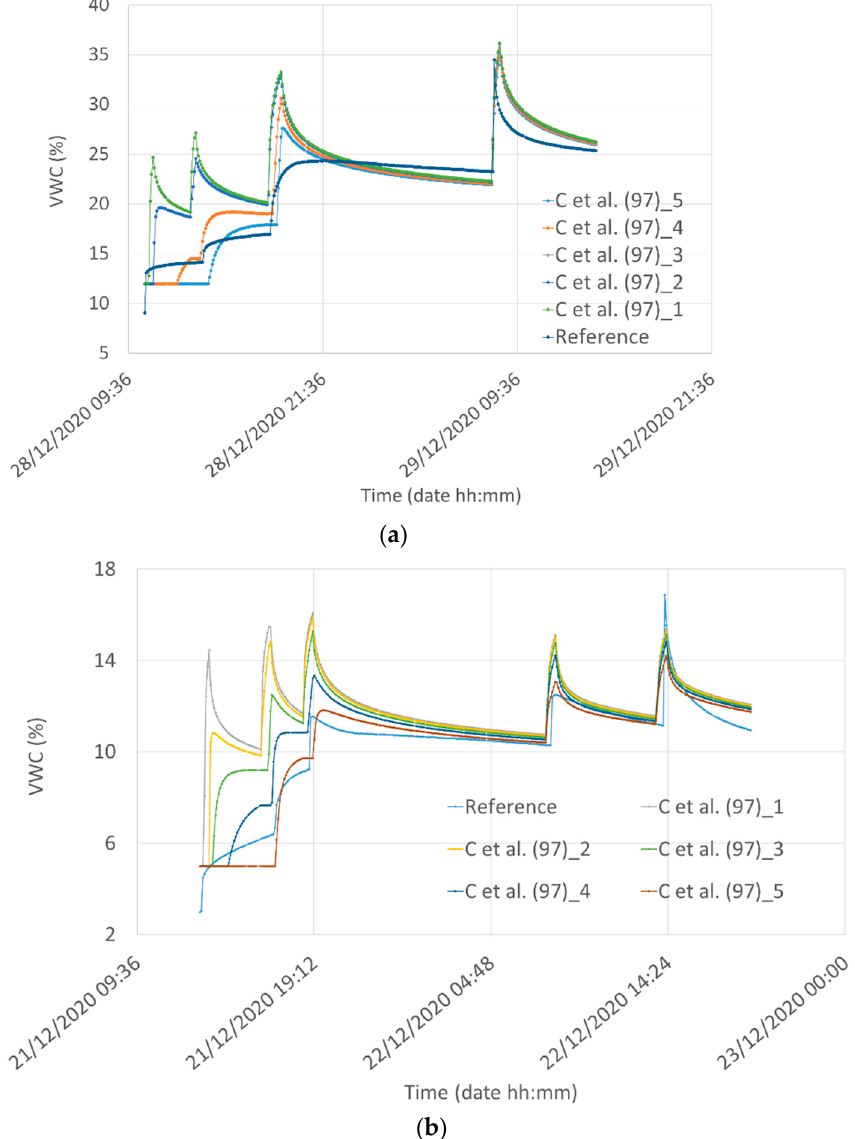
Figure 18. Modeling results for infiltration and redistribution of water (“C et al. (97)” model) during and after rainfall at different depths (1, 2, 3, 4, and 5 cm) for ( a ) Silty Loam and ( b ) Loamy Sand. The model was calibrated with respect to the measured values at a 5 cm depth (Reference sensor). For example, in the figure “C et al. (97)_1” stands for the modeling result at a 1 cm